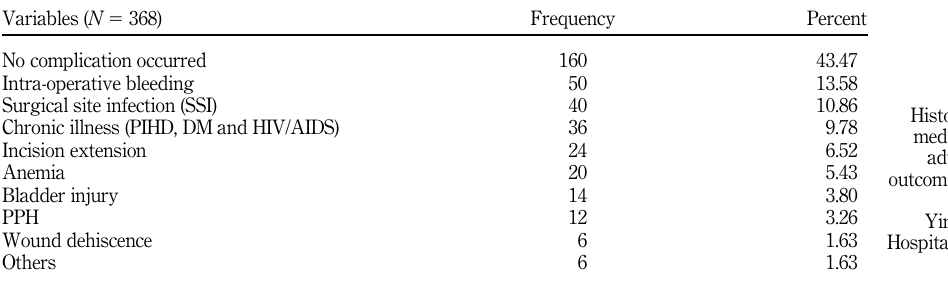
Figure 2. Common indications